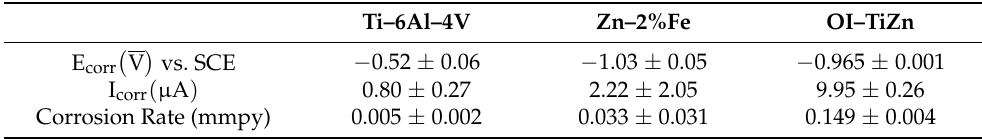
Figure 11. Potentiodynamic polarization analysis of Ti–6Al–4V lattice, Zn–2%Fe alloy, and OI–TiZn system in PBS solution. Table 2. The results obtained by Tafel extrapolation including statistical deviations.